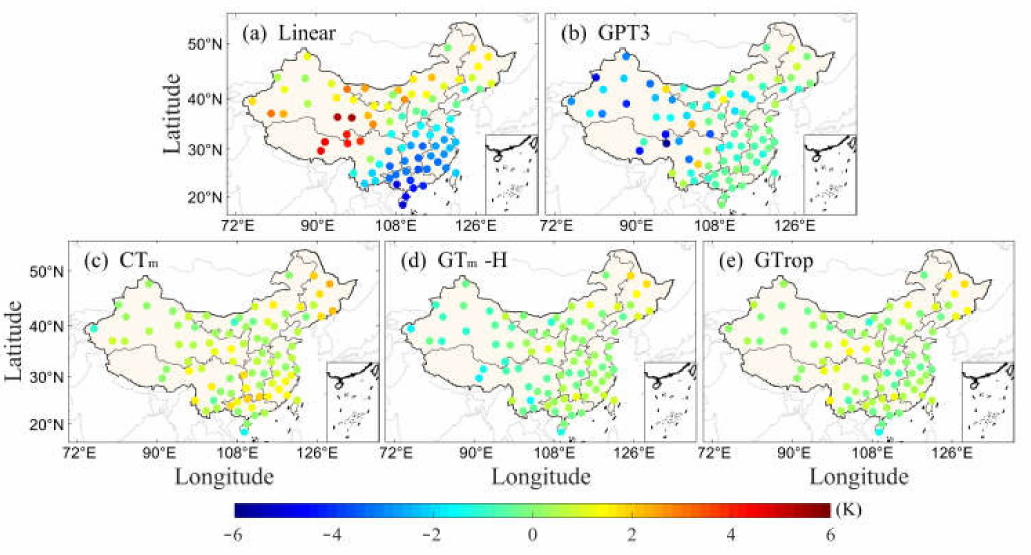
Figure 9. Bias distribution of the T m difference between the five T m models and the 87 RS stations in China over the period of 2011 to